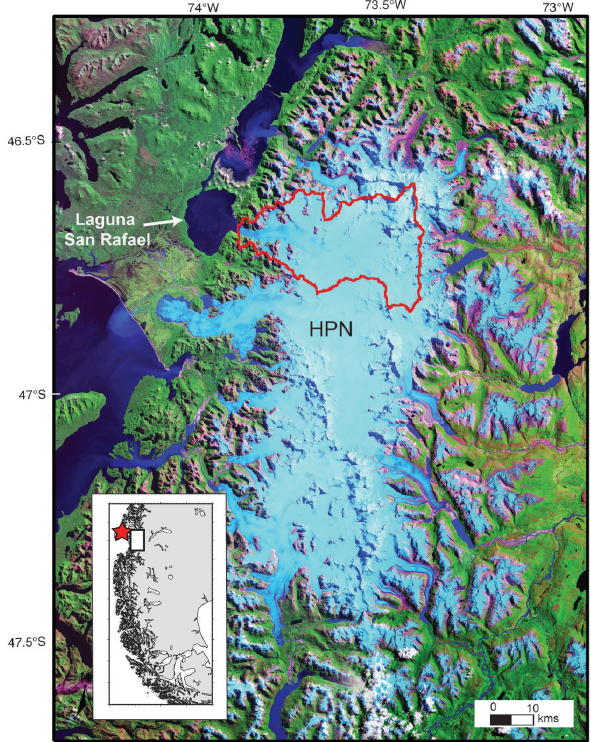
Fig. 1. Location of Glaciar San Rafael in the Campo de Hielo Patagonico Norte (HPN), Chile. Solid-line marks map extent of the glacier; dashed-line indicates present-day equilibrium line (about 1300ma.s.l.). The glacier calves into Laguna San Rafael (LSR), which is connected to ocean waters through the Rio Tempano. The star shown in the inset map is the location of the NCEP-NCAR grid point SR1 at 46.67 ◦ S, 75 ◦